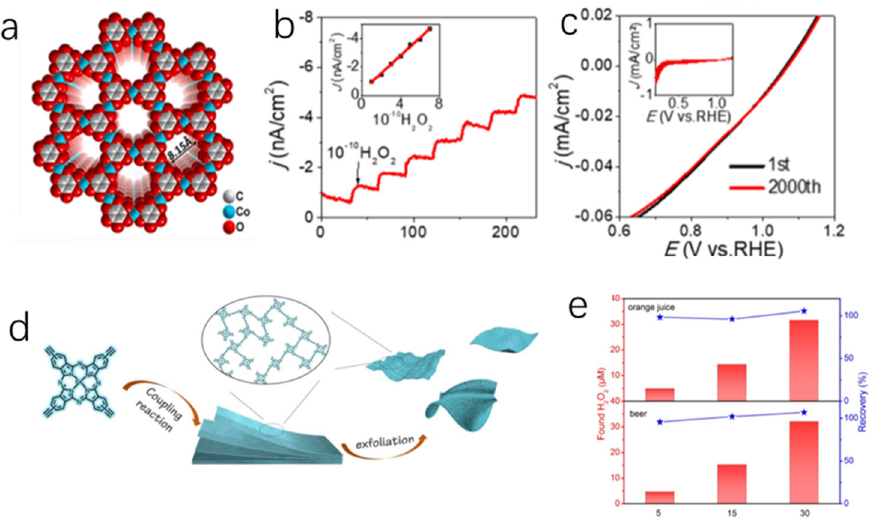
Figure 3. ( a ) The space-filling model of [Co 3 (HOB) 2 ] n ; ( b ) H 2 O 2 injection responses of the current density of 3-layer [Co 3 (HOB) 2 ] n films (The inset shows the linear relationship between the current density and the injected H 2 O 2 amount.); ( c ) Tolerance of regular species. LSV curves before/after 1000 CV cycles. (The inset shows the 1000-cycle CV curves.) [36]; Copyright 2021, Elsevier. ( d ) Schematic diagram for the synthesis of the FePc-CP NSs; ( e ) Determination of H 2 O 2 in commercial orange juice and beer [ 55 ]. Copyright 2019, ACS.